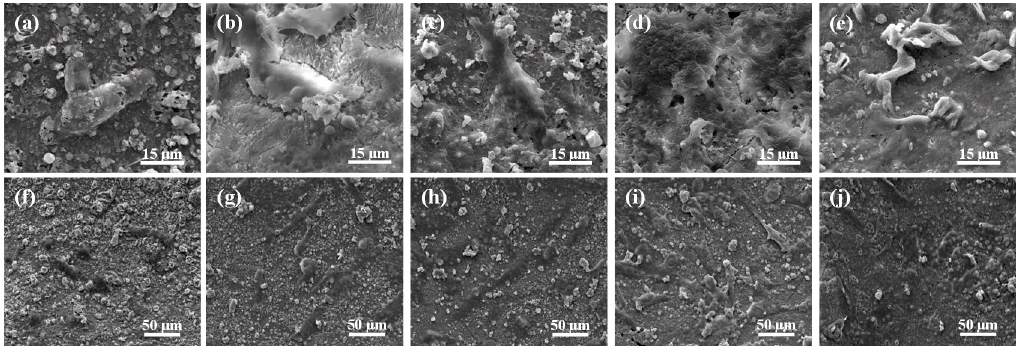
Figure 7. Morphology of osteoblast-like cells seeded on the scaffolds with ( a , f ) 0 wt %; ( b , g ) 1 wt %; ( c , h ) 3 wt %; ( d , i ) 5 wt %; and ( e , j ) 10 wt % ZnOw for one day.